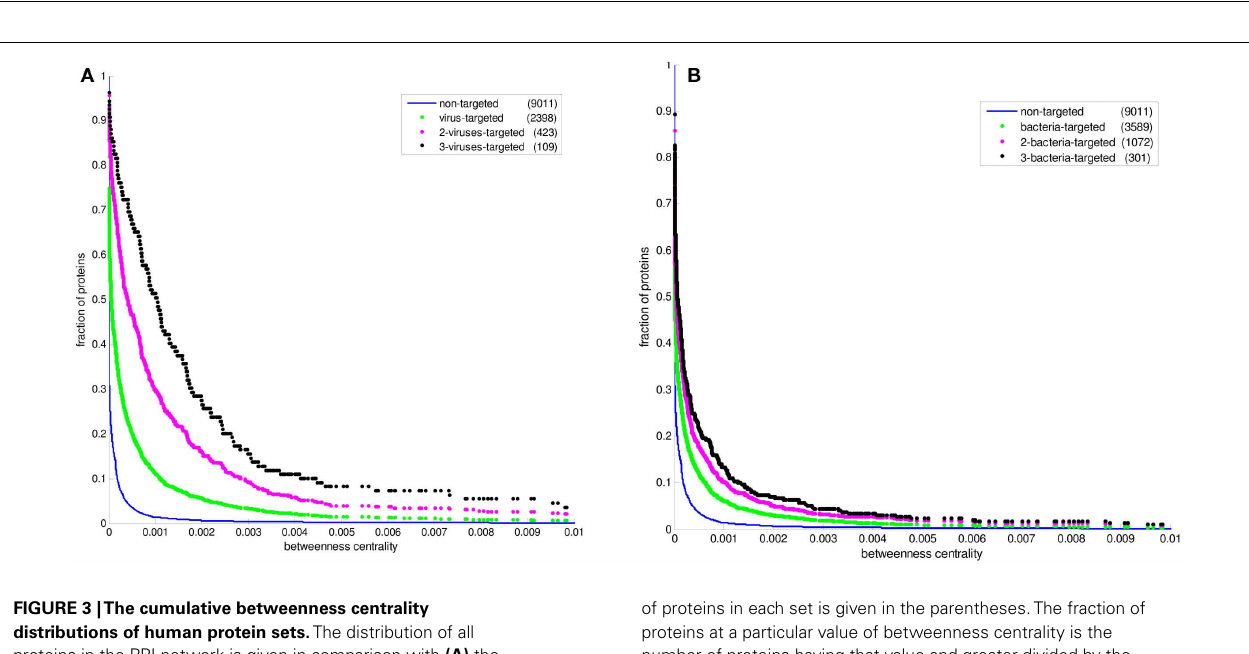
FIGURE 3 |The cumulative betweenness centrality distributions of human protein sets. The distribution of all proteins in the PPI network is given in comparison with (A) the bacteria-targeted sets, and (B) the virus-targeted sets.The number